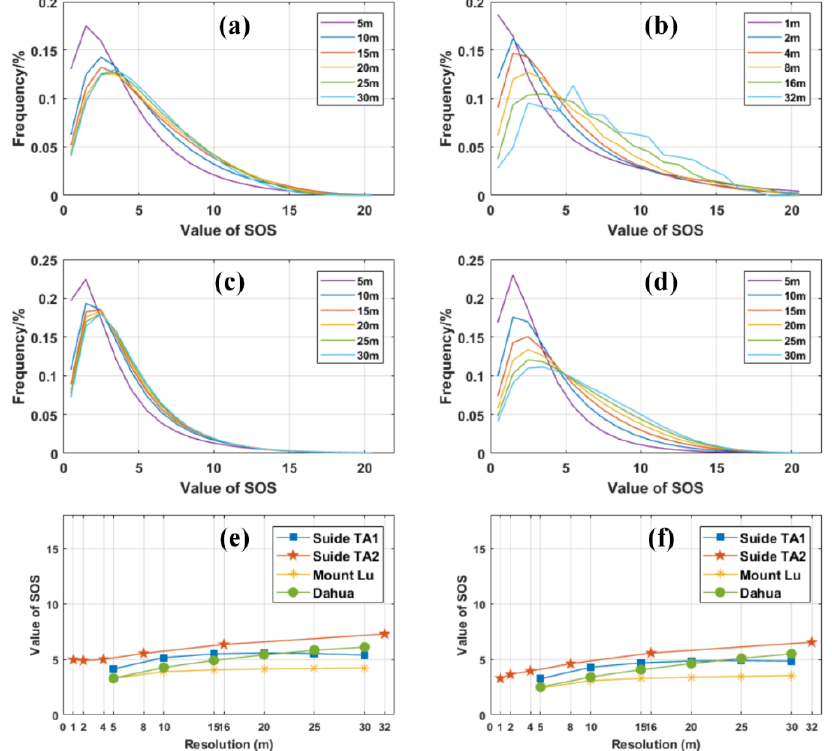
Figure 12. Statistics of the SoS results based on different resolutions using the vector method in different areas. ( a ) Suide TA1, ( b ) Suide TA2, ( c ) Mount Lu, ( d ) Dahua, ( e ) mean values, and ( f ) median values.